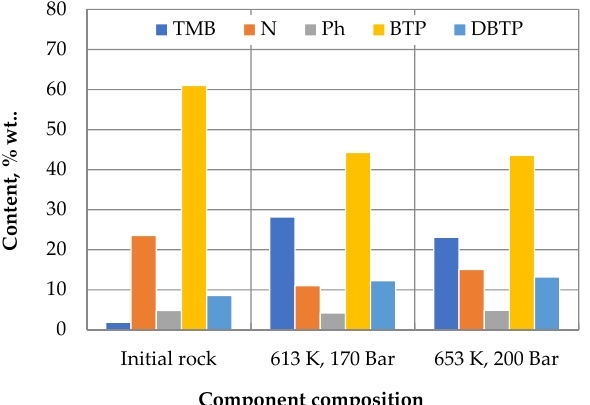
Figure 5. Distribution of various types of aromatic hydrocarbon compounds in extracts from carbonate rocks before and after experiments.